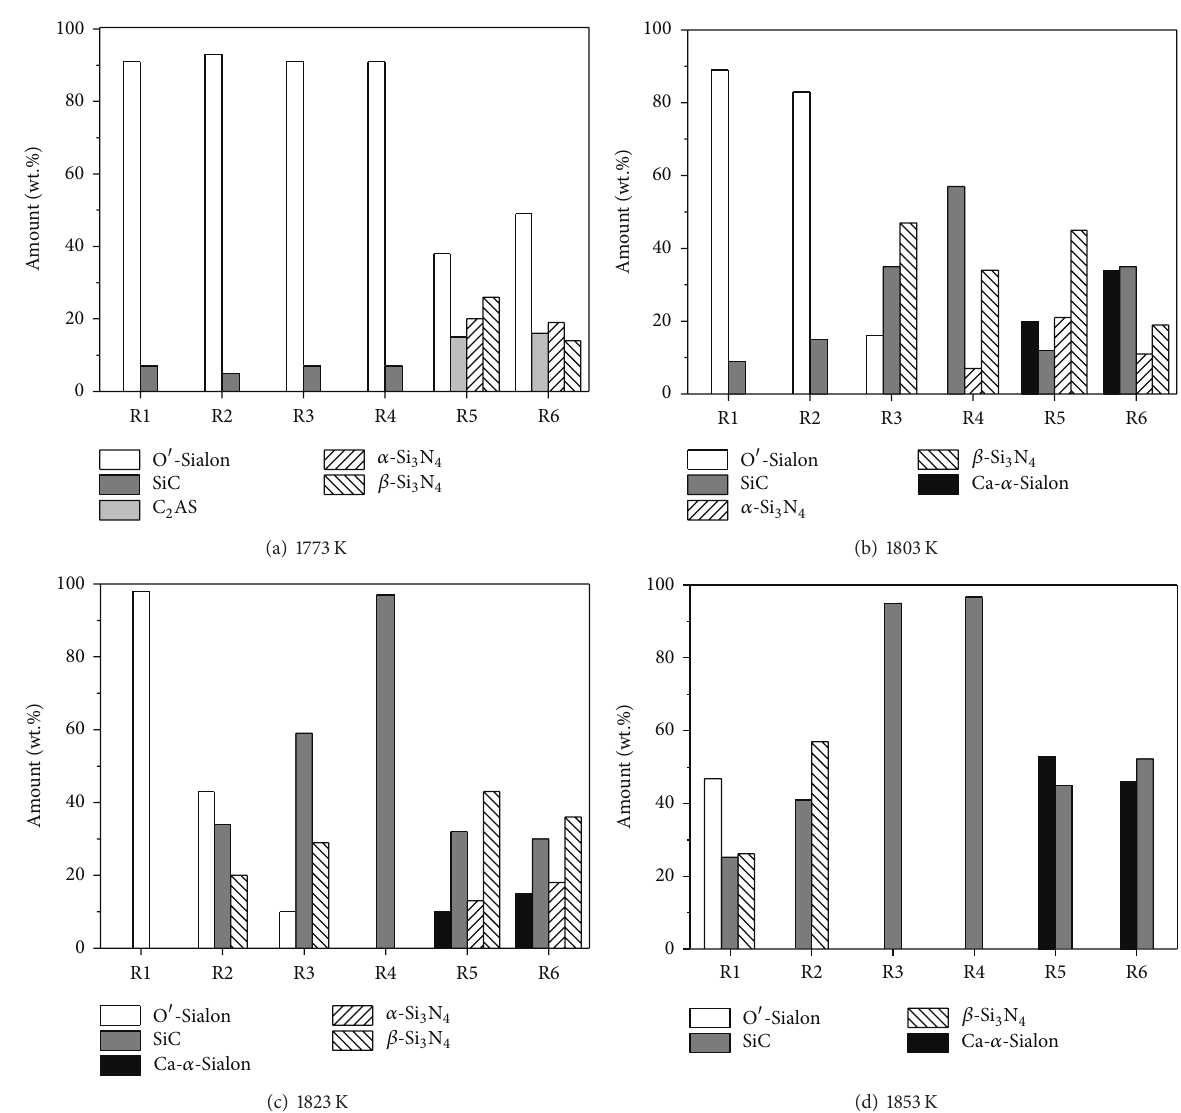
Figure 3: Relative phase compositions of samples after calcination at different temperatures for 3